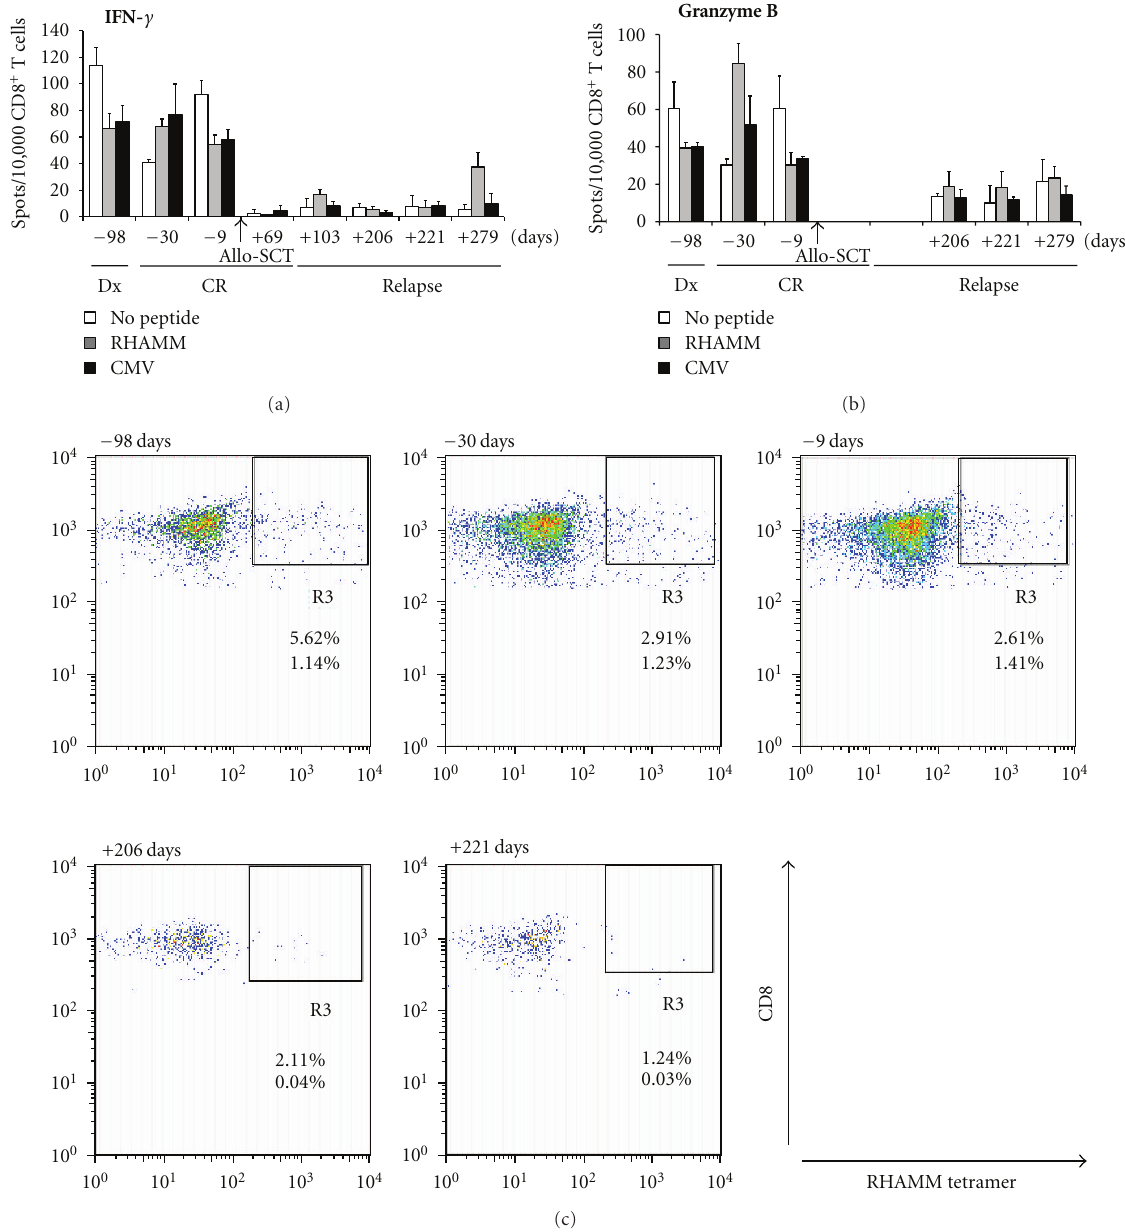
Figure 3: Longitudinal study of RHAMM-specific CTLs in a patient with AML that received allo-SCT. PBMCs were collected from an AML patient at di ff erent time points before or after allo-SCT as indicated and subjected to MLPC. CD8 + T cells showed RHAMM-specific release of IFN- γ (a) and granzyme B (b) at one time point (30 days prior to transplant) when the patient was in CR. This active T-cell population was lost after allo-SCT and not reconstituted when the patient relapsed. (c) CD8 + T cells were stimulated with RHAMM peptide and stained with respective tetramer. Frequencies of RHAMM-specific CTLs vanished over the time, as detected by flow cytometry. Reported frequencies correspond to the gate of CD3 + CD8 + T cells (upper numbers) and to all cells in the lymphocyte gate (lower numbers).